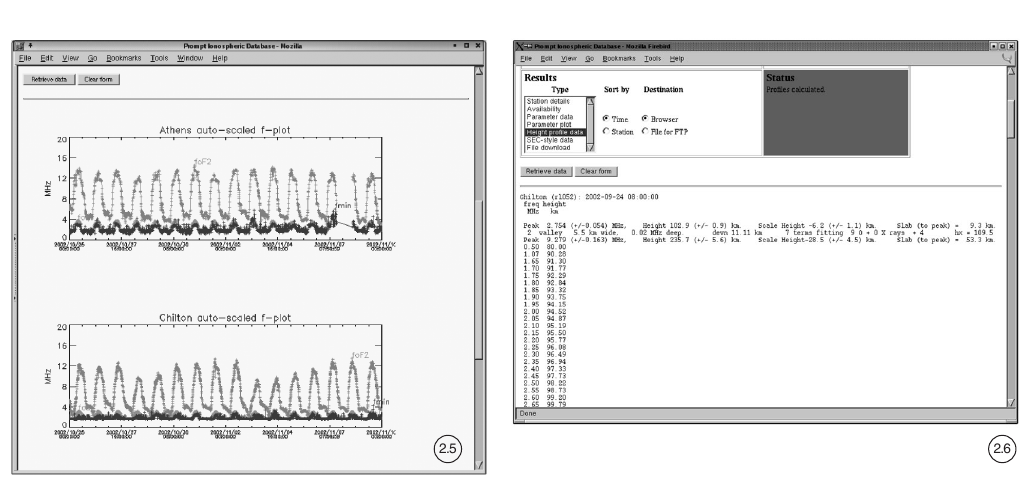
Fig. 2.5. Plot of ionospheric parameters over along time interval from the Prompt Ionospheric Soundings- Database. Fig. 2.6. True-height analysis using POLAN from the Prompt Ionospheric Soundings Database.